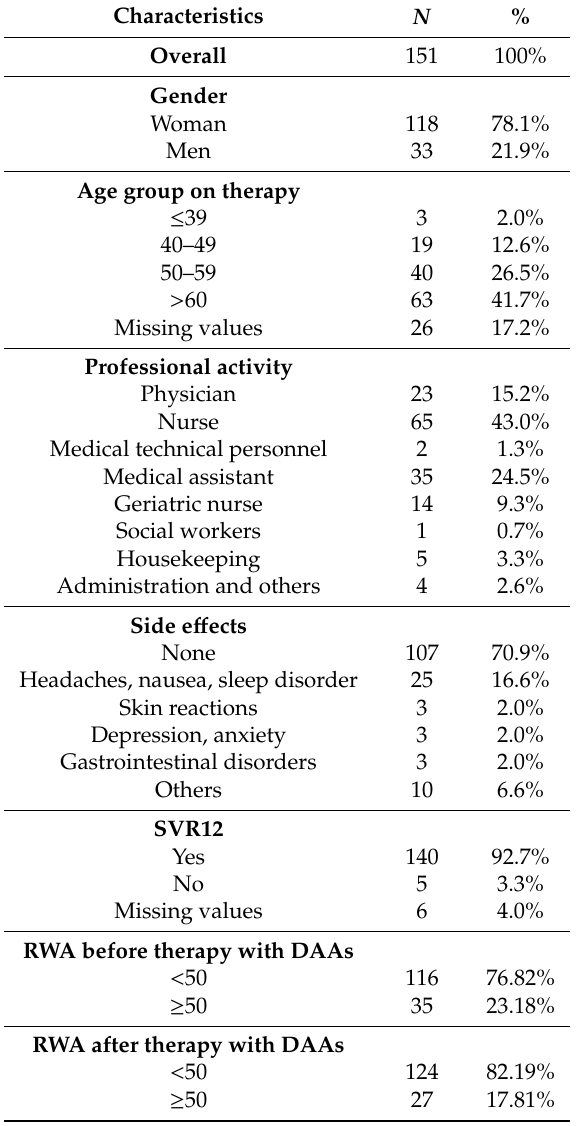
Table 3. Description of the study